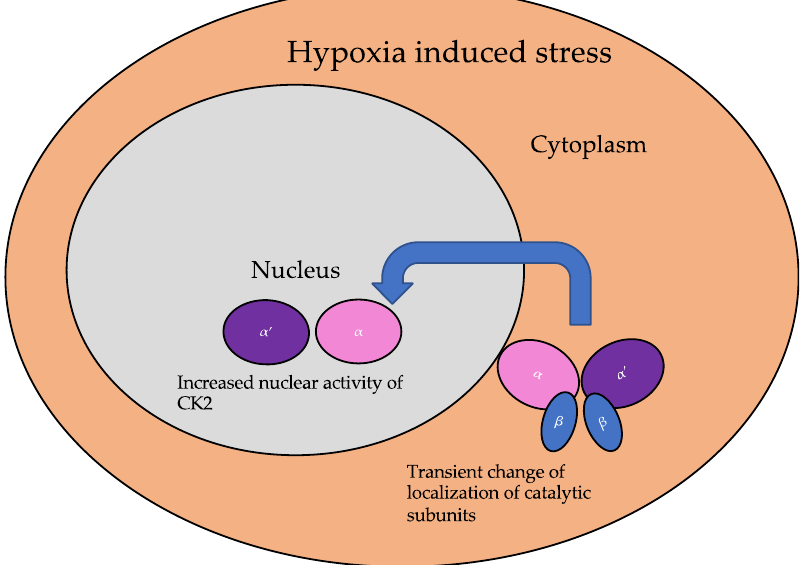
Figure 4. The localization of the catalytic subunits of CK2 is altered during hypoxia. Specifically, these subunits are translocated to the nucleus transiently to aid the cellular response to hypoxia.